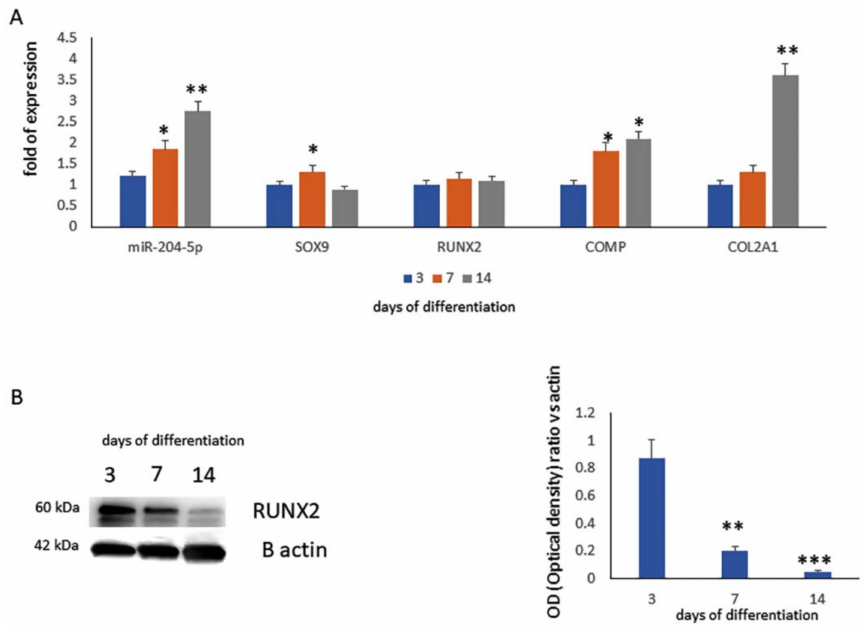
Figure 1. ( A ) MiR-204-5p and chondrogenic (SOX9, RUNX2, COMP, COL2A1) mRNA expression levels quantified by RT-PCR after 3, 7 and 14 days of chondrogenic differentiation in an MSCs in vitro model. RUNX2 protein expression levels assessed ( B ) by western blot analysis (left side) and quantified as a relative optical density ratio vs. B-actin (right side) on a protein lysate from an MSCs in vitro model after 3, 7 and 14 days of chondrogenic differentiation. (* p < 0.05; ** p < 0.005; *** p < 0.001 vs. expression levels of MSCs after 3 days of